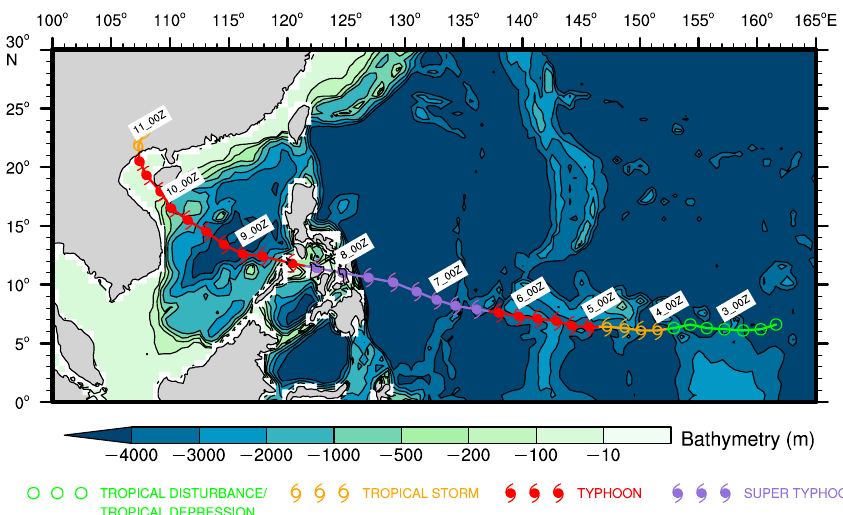
Figure 1. Best track of super-typhoon Haiyan showing the trajectory and the intensity.